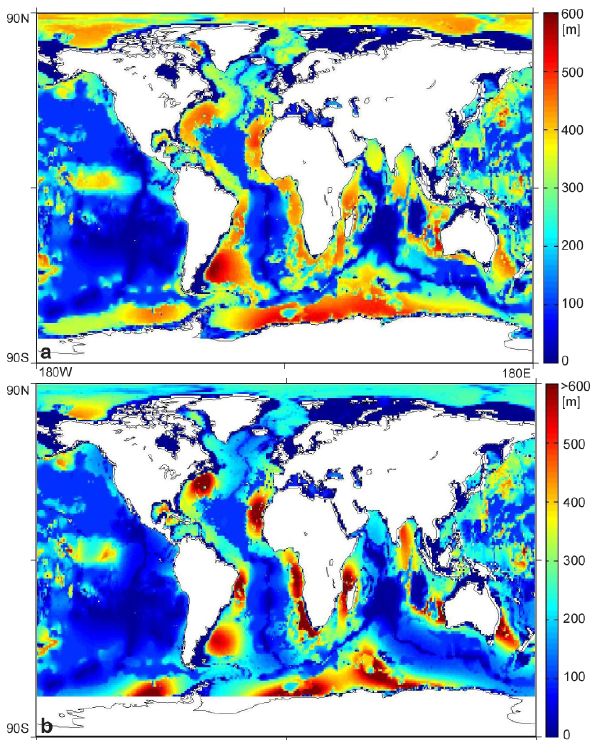
Fig. 4. Global distribution of the thickness of the gas hydrate stabil- ity zone ( L GHSZ ): (a) geothermal gradient was calculated after the harmonic function of Hamza et al. (2008) to calculate heat flow and considering a thermal conductivity of 1Wm − 1 K − 1 ; (b) geother- mal gradient was calculated after the harmonic function published by Pollack et al. (1993) and considering a thermal conductivity of 1Wm − 1 K − 1 . See Sect. 3.3 for further